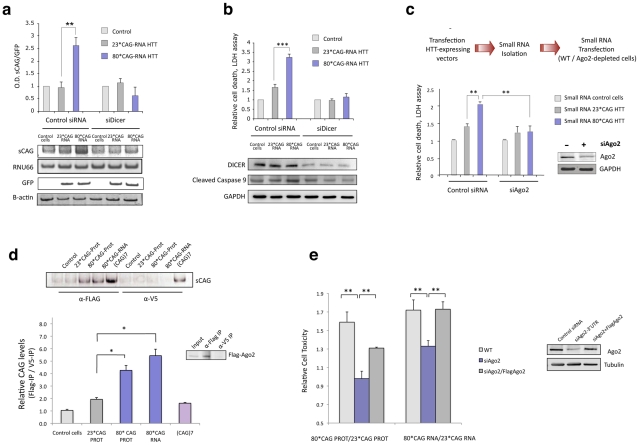
sCAG neurotoxic effect is dependent on Dicer and Ago proteins.A. Dicer knockdown inhibits the generation of sCAGs produced by the expression of 80*CAG HTT-e1. sCAG levels were normalized to RNU66 levels. GFP blots indicate the expression of the HTT-constructs (n = 3; interaction p-value = 0.000138; F = 46.220). B. In the same experiments, cell viability and caspase 9 cleavage analysis show that Dicer depletion mitigates cell death induced by expanded HTT (n = 5; interaction p-value = 0.000135; F = 18.263). C. Ago2 depletion mitigates the toxicity of sRNA obtained from mutant HTT expressing cells (n = 3; interaction p-value = 0.011; F = 10.821). D. sCAG efficiently associate to Ago2 in vivo. HTT-expressing constructs were transfected on cells stably expressing Flag-Ago2. Flag IP demonstrate that sCAG binds to Ago2 complex. No significant binding was detected in control IP experiments (α-V5). The plot shows the mean ratio of sCAG levels in FLAG IP vs. control V5 IP (n = 3; *p<0.05). E. The expression of Flag-Ago2 in cells depleted for endogenous Ago2 partially, but significantly, rescued CAG-expanded HTT toxic effect (n = 3; *p<0,05). Values represent the mean of the ratio expanded-HTT sRNA toxicity vs non-expanded-HTT sRNA toxicity ± SEM in each experimental condition. Toxicity levels are referred to the control cells lacking HTT expression. In A. B. and C., values represent the mean fold change with respect to the control, non-transfected cells ± SEM. Cells were processed 24 hours after double transfection in all the experiments.